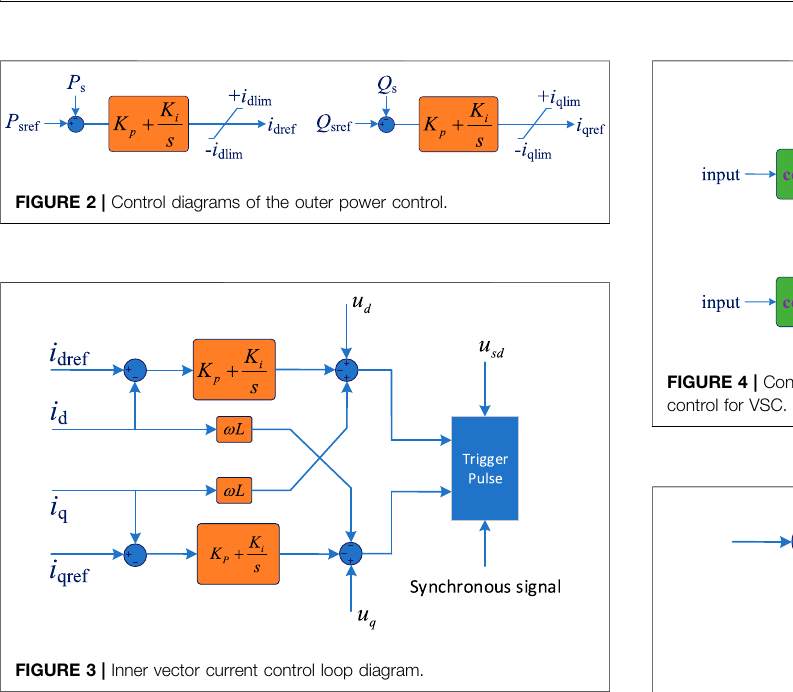
FIGURE 1 | Control diagram of VSC-HVDC.